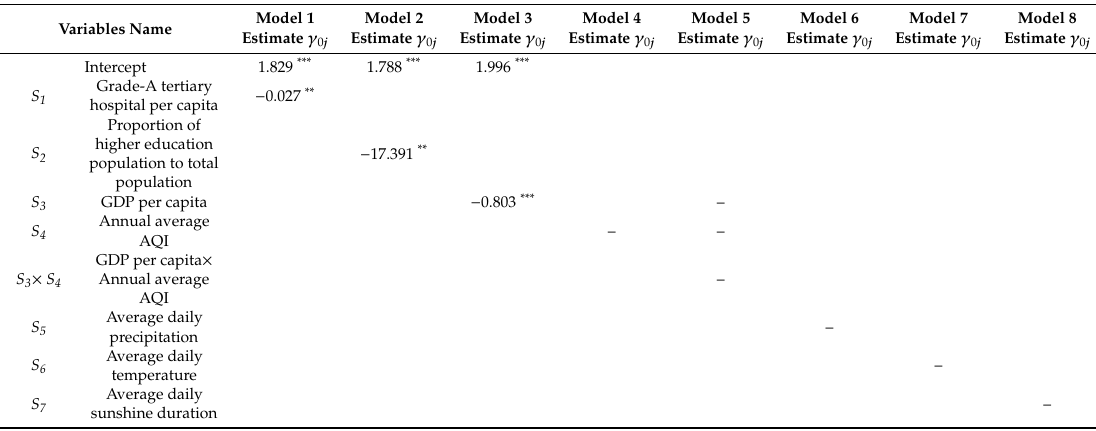
Table 3. Determinants for health inequality at the provincial